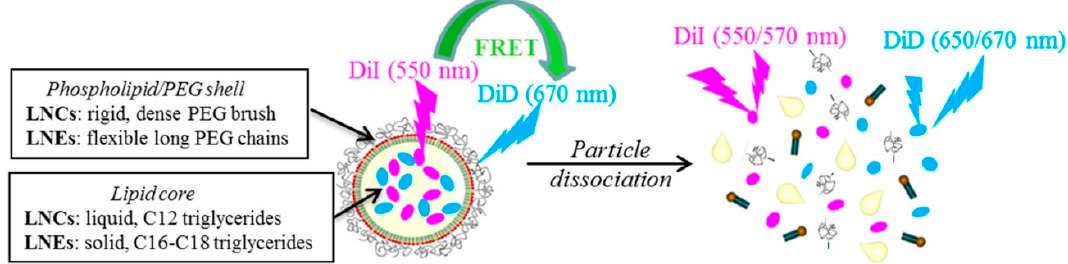
Figure 8. Schematic representation of the particles and the FRET process. Reproduced with permission from ref. [10]. Copyright 2014, American Chemical Society.